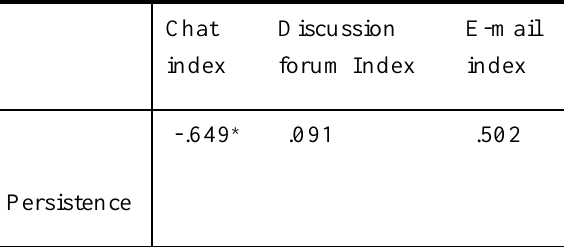
Correlation Coefficient Between the Instructional Interaction Methods and the Persistence